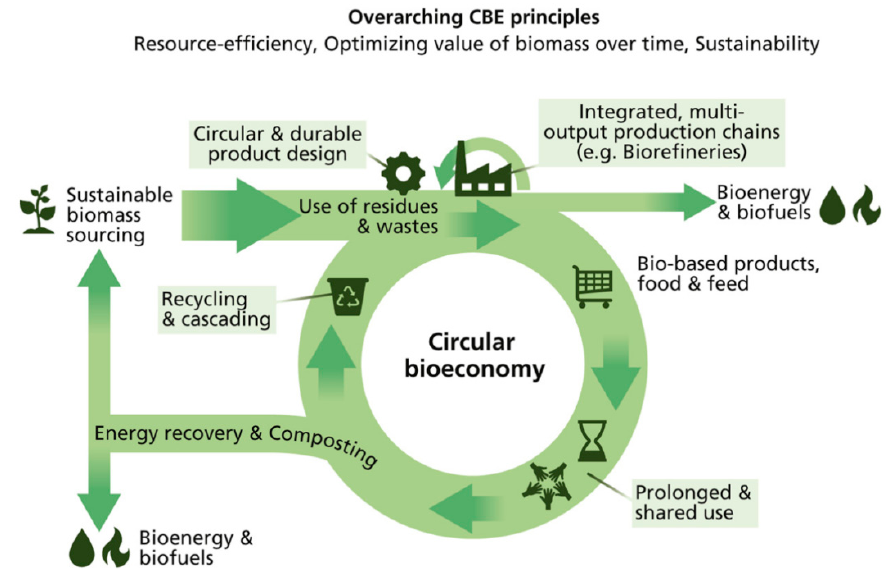
Figure 1. The concept of the circular bioeconomy (CBE) and its elements. Adapted from the ref. [6] .